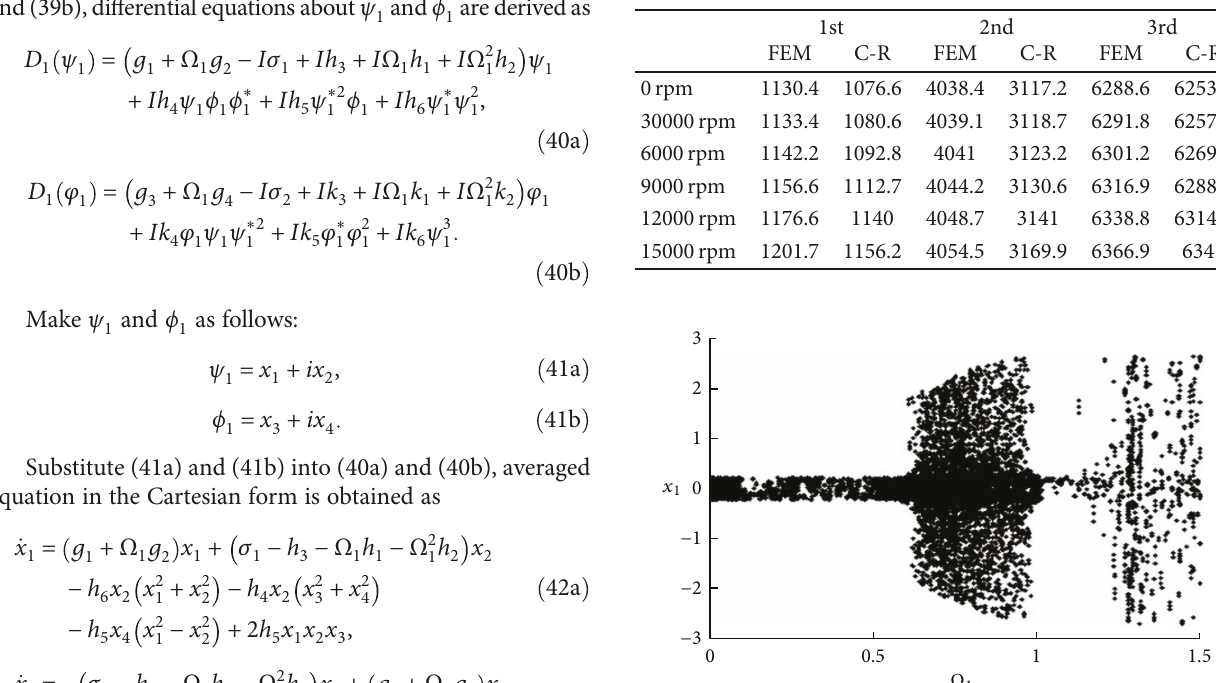
Table 1: Frequency comparison.